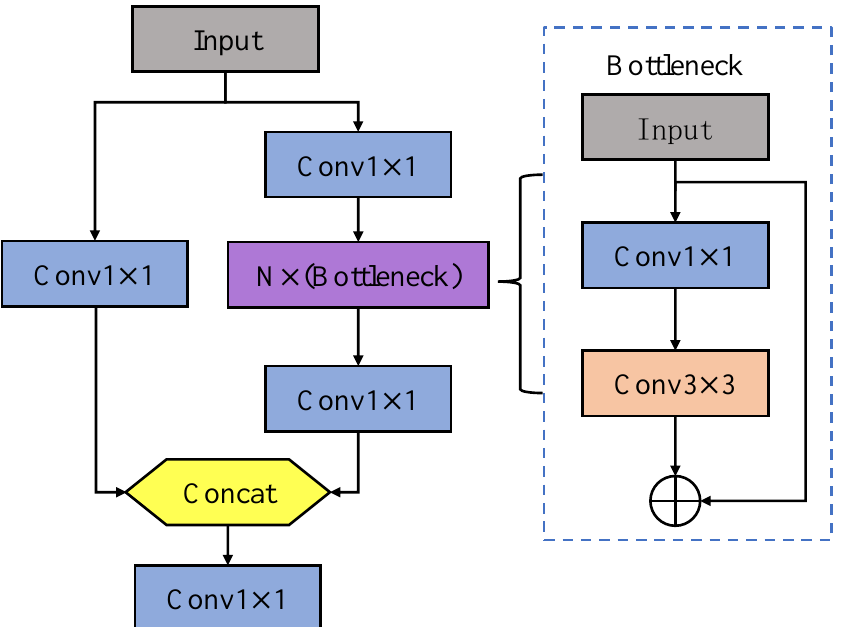
Figure 5. C3 bottleneck block structure.